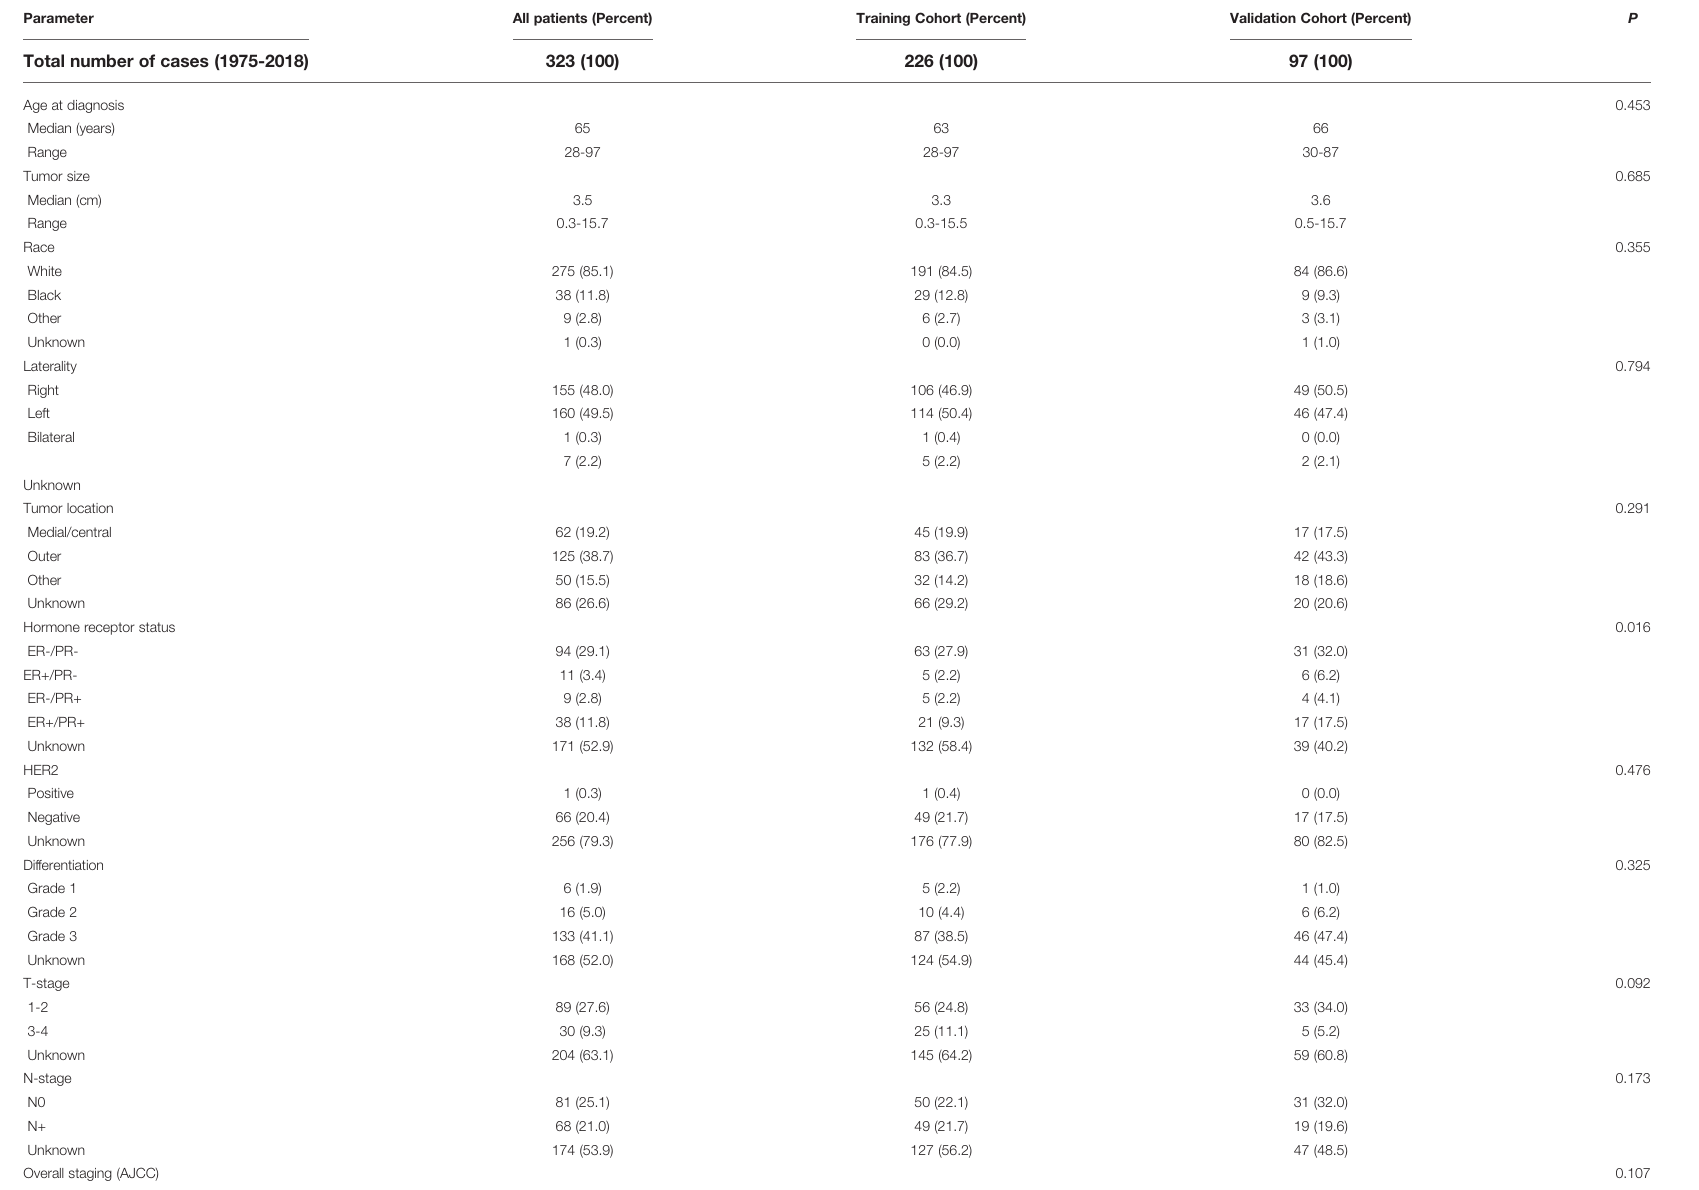
TABLE 1 | Patient, tumor and treatment